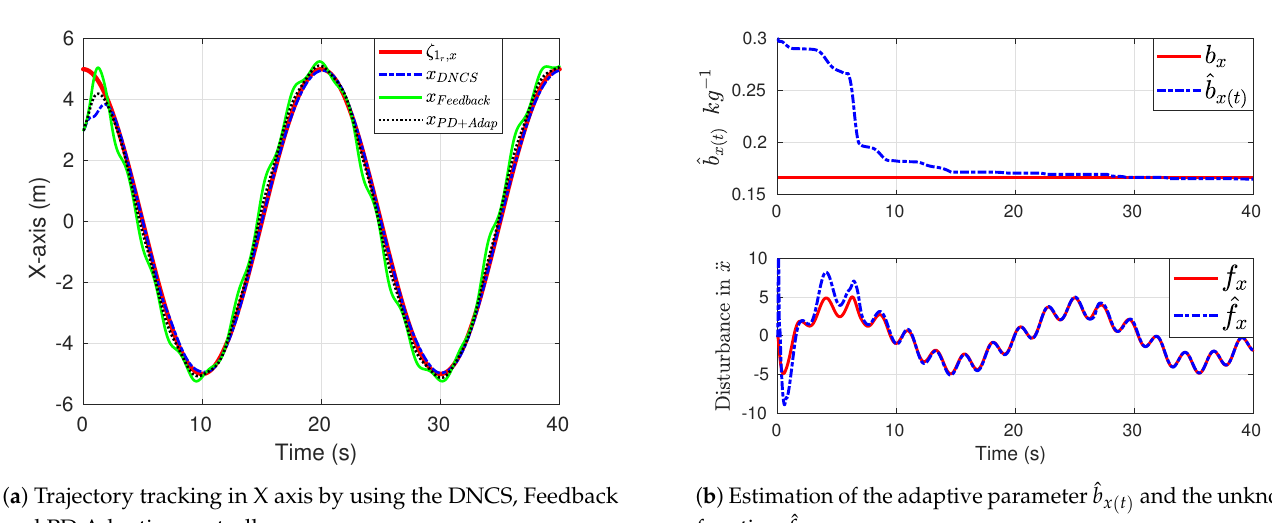
( b ) Estimation of the adaptive parameter ˆ b x ( t ) and the unknown function ˆ f x . Figure 6. Simulation results for trajectory tracking of a 3D helical reference signal in the X axis.